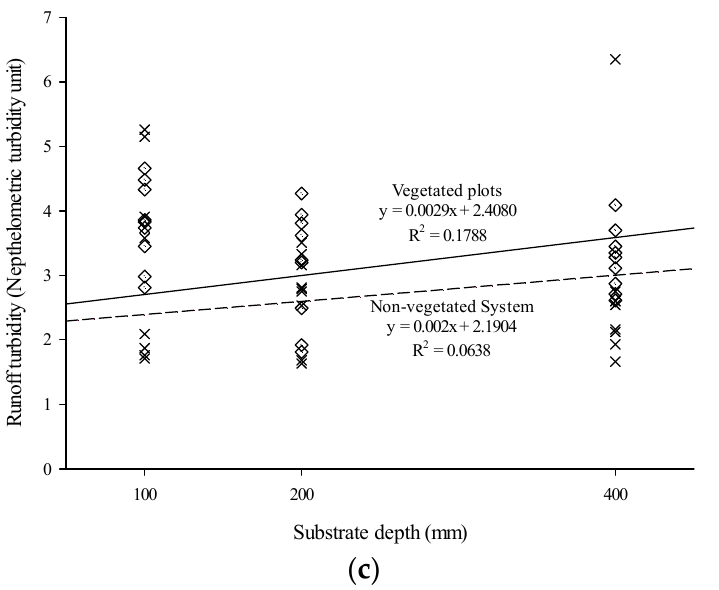
Figure 3. Relationship between substrate depth and pH ( a ), EC ( b ), and turbidity ( c ) from vegetated or non-vegetated plots.